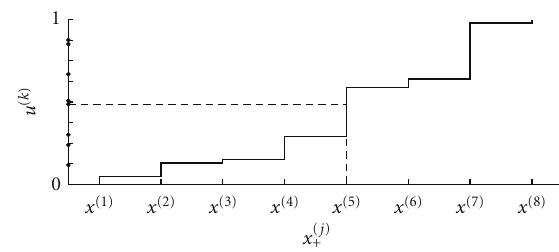
Figure 5: Particle selection by comparing uniform random num- bers ( • ) to the cumulative sum of particle weights (–).